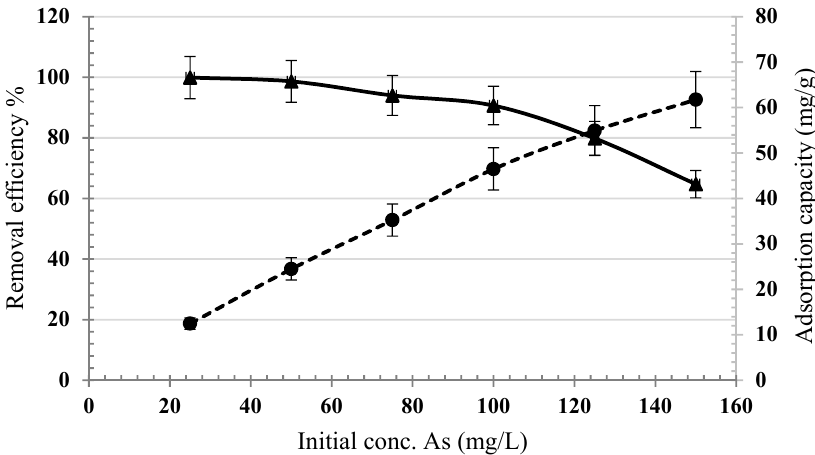
Figure 9. E ff ect of initial arsenic concentration on arsenic removal e ffi ciency (sorbent dosage: 2 g / L,